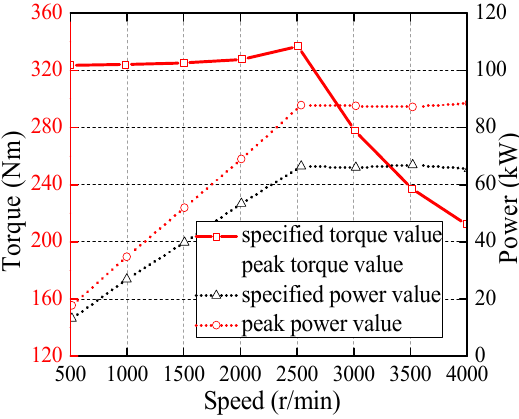
Figure 4. Full load torque and power characteristics of the generator.